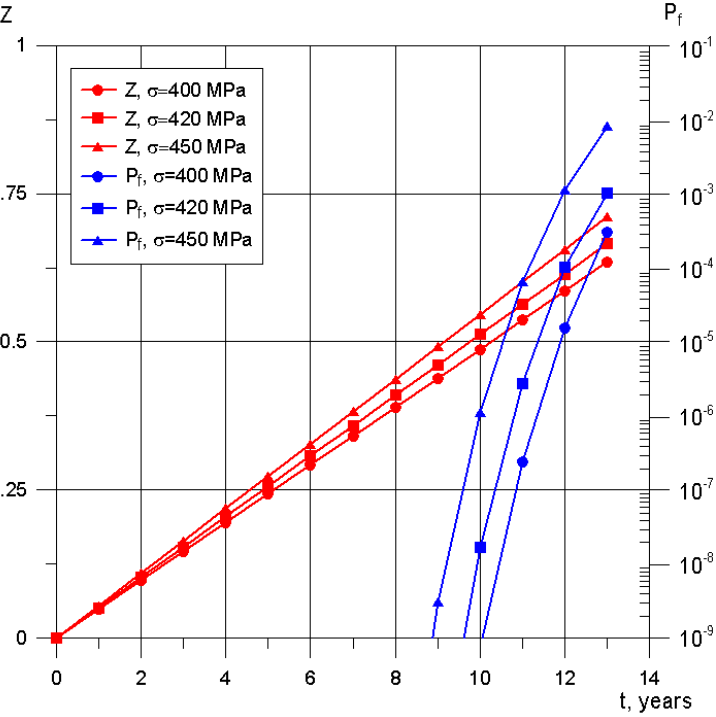
Figure 6. Material fatigue-creep wear and probability of turbine rotor failure over 13 years of oper- ation, 𝑍 0 = 0 . operation, Z 0 =